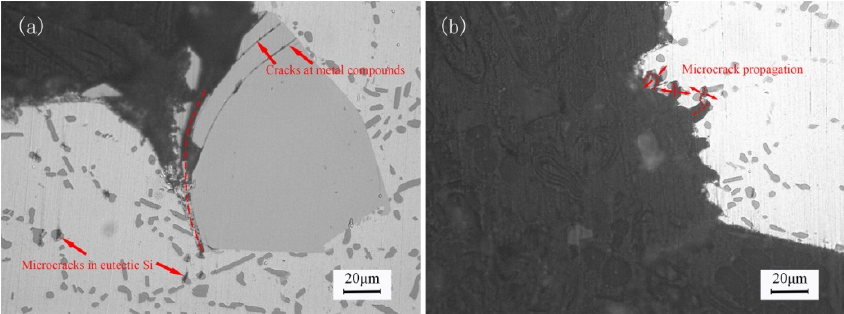
Figure 20. Optical micrographs of side views of fractured A357 modified alloy tensile samples. ( a ) Side views 1 ( b ) Side views 2.